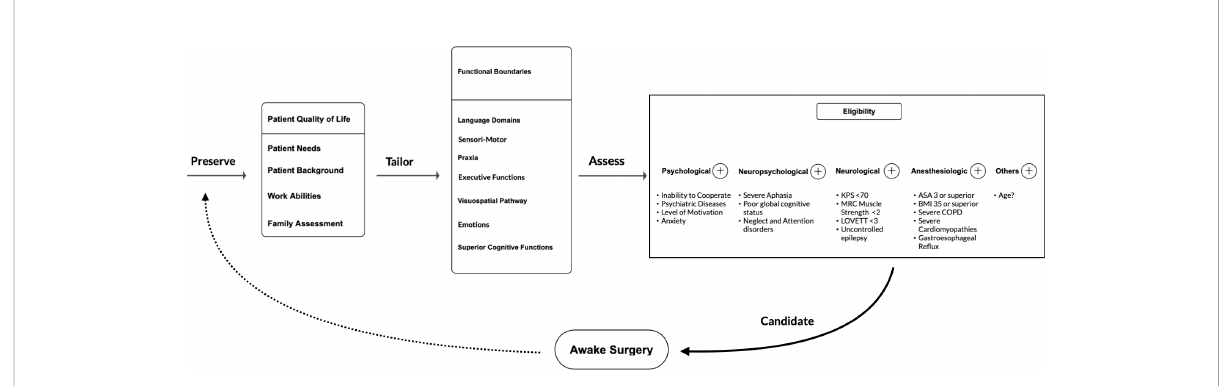
FIGURE 5 Flow-chart of the proposed patient selection process for indication and eligibility to AS suggested by the authors on the basis of this scoping review